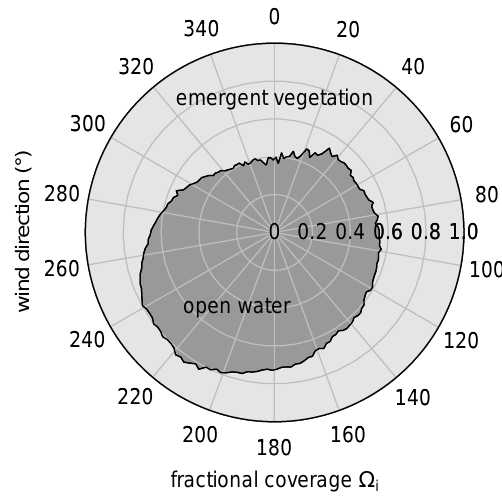
Figure 5. Source area fraction (cid:127) i of the two main surface types in dependence on the wind direction (2 ◦ bins). Figure 6. Impact of the fractional coverage of open water ( (cid:127) water )